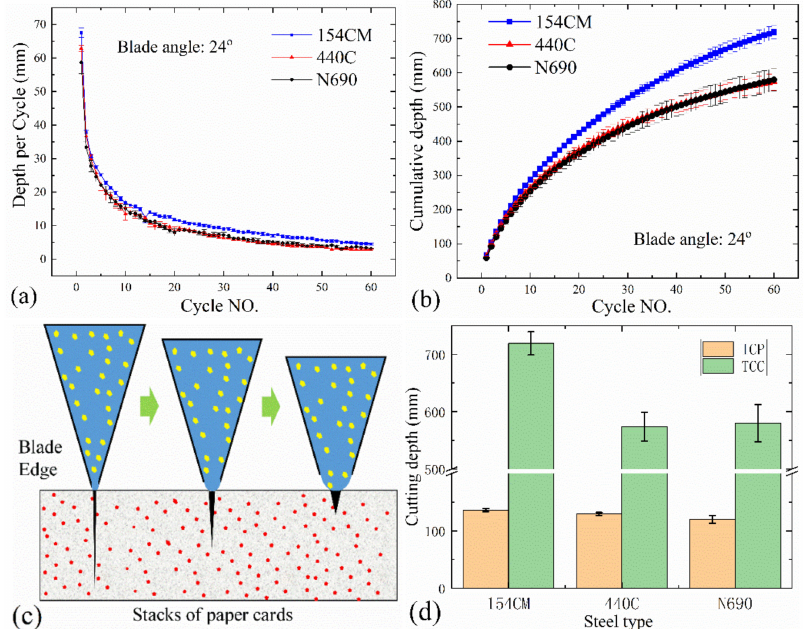
Figure 8. Cutting depth per each cycle ( a ) and cumulative cards cutting performance ( b ) of the MSS blades during the CATRA sharpness test revealed the degradation of blade sharpness ( c ), and ICP and TCC ( d ) of the MSS blades were calculated and compared.